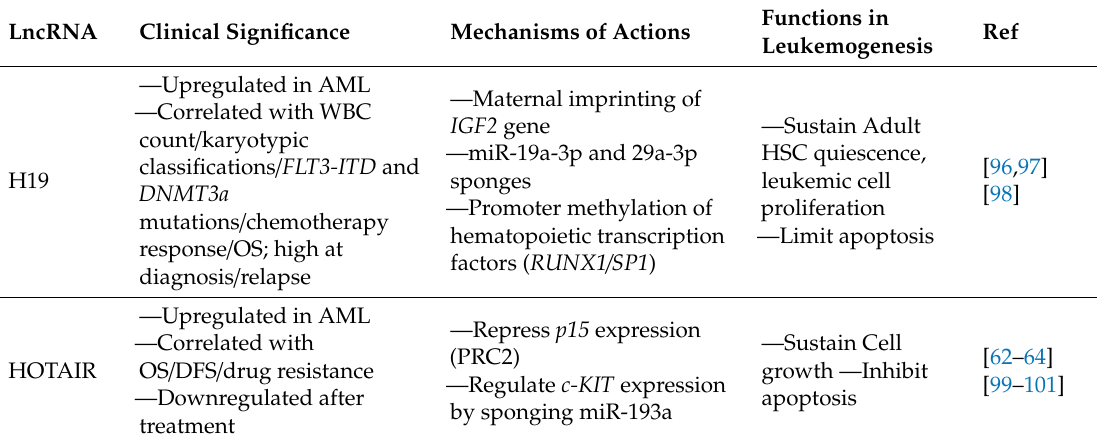
Table 1. Oncogenic lncRNAs in Acute Myeloid